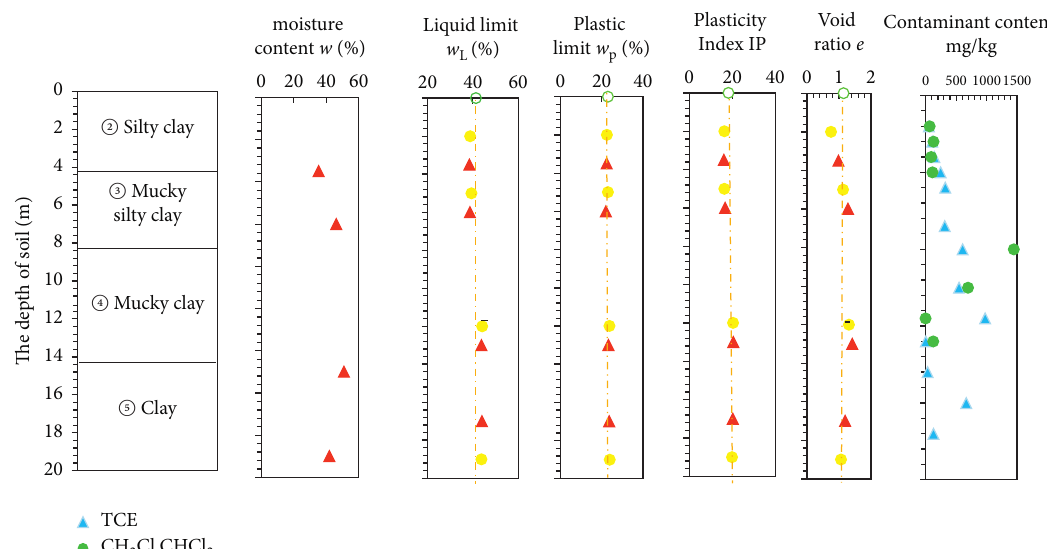
Figure 1: Soil layer distribution and basic physical and mechanical indexes.